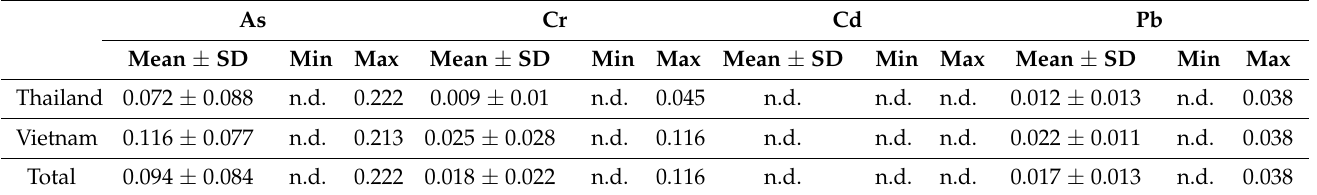
Table 2. The level of As, Cr, Cd, and Pb (mg/kg) of samples detected in the study East Asian bullfrog. Cd was not detected in any sample. Entries n.d. = not detected.